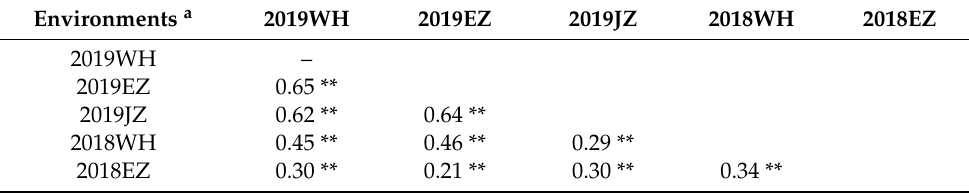
Table 3. Pearson correlation coefficients of the FHB index across different environments. Environments a 2019WH 2019EZ 2019JZ – Environments a 0.65